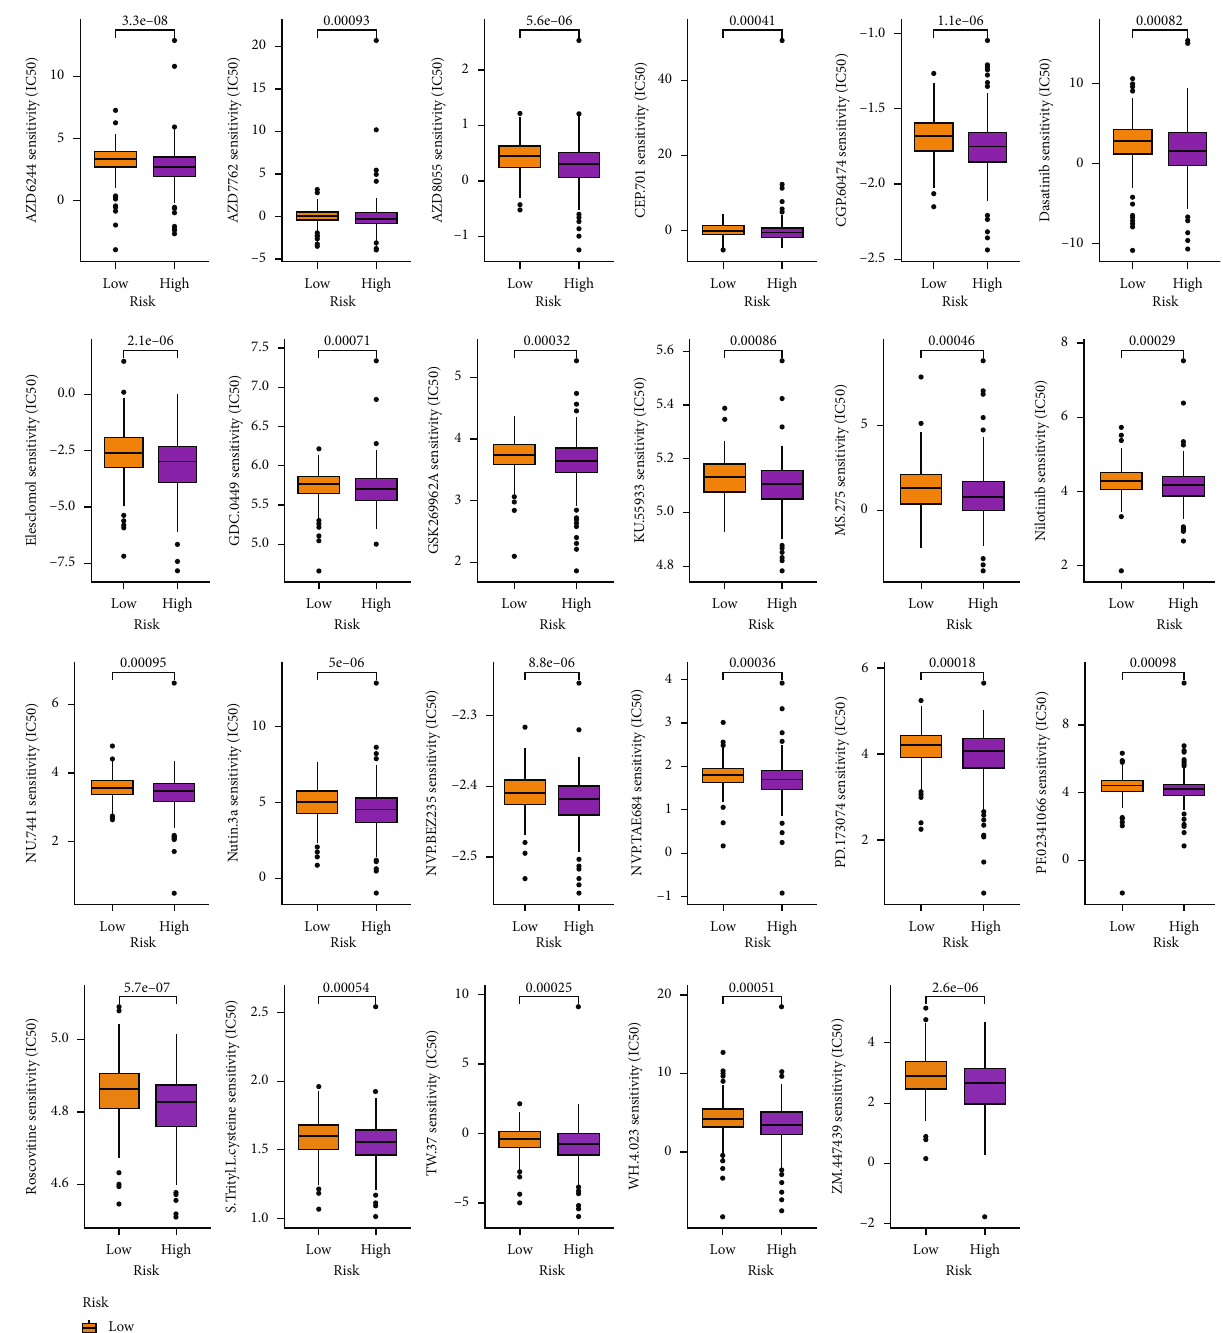
Figure 8: Selection of antitumor